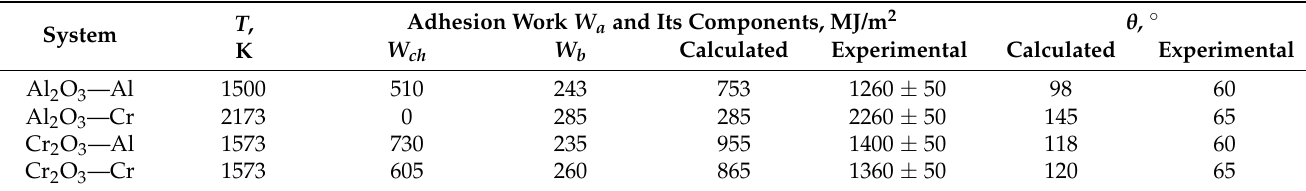
Figure 8. Interface between the aluminum droplet (brighter area on the left) and chromium oxide substrate (darker area on the right) obtained at T = 1200 °C and Р = 10 – 2 MPa. Numbers #1 – #6 indicate places where chemical analysis was made. Table 4. Contact angles and energy characteristics of the MeO – Me systems.